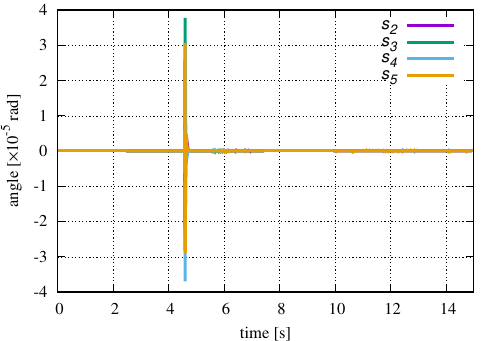
Figure 20. Case 2: Time variation of estimation error of the twist angle of the springs.